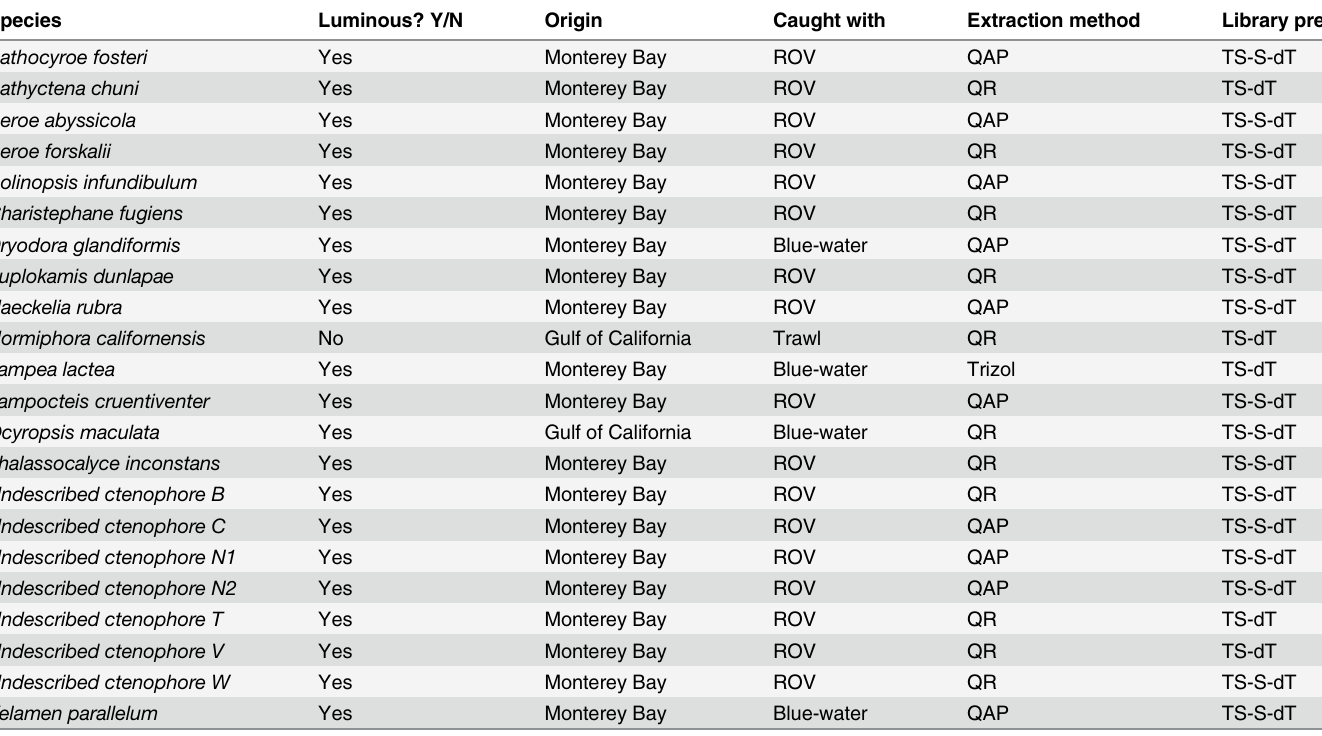
Table 1. List of